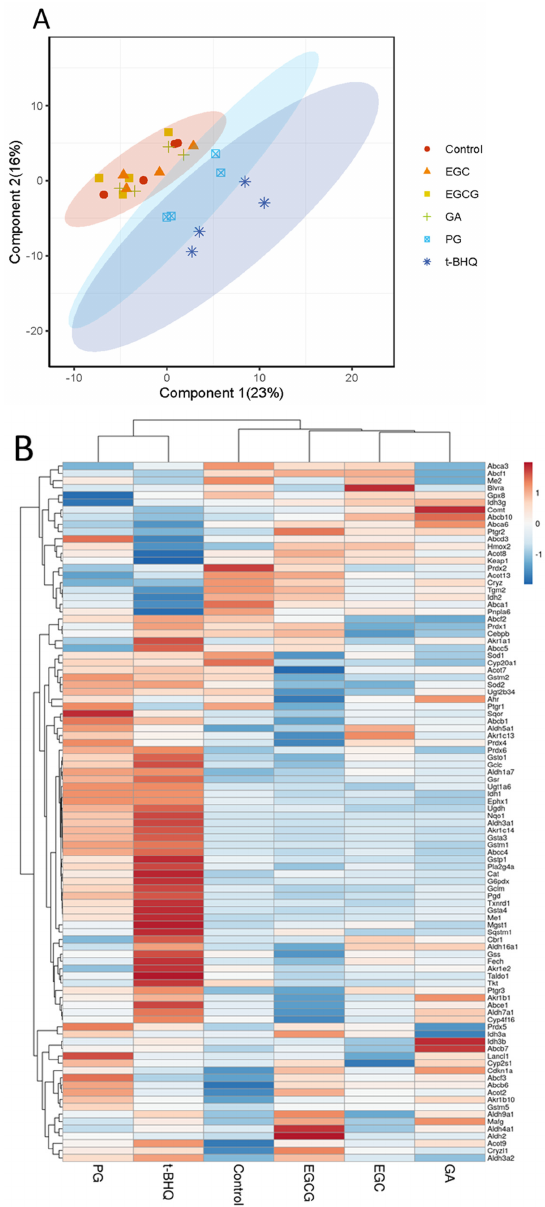
Figure 3. Principal component analysis (PCA) scatter plot ( A ) and heatmap ( B ) based on the expression levels or protein fold changes (FCs) of 97 Nrf2-related proteins in different treatments of Hepa1c1c7 cells. Results derived from four independent experiments. EGCG, ( − )-epigallocatechin gallate; EGC, ( − )-epigallocatechin; GA, gallic acid; PG, pyrogallol; t-BHQ, tert-butylhydroquinone. Full form of the abbreviated protein names can be found in Supplementary Materials Table S2.